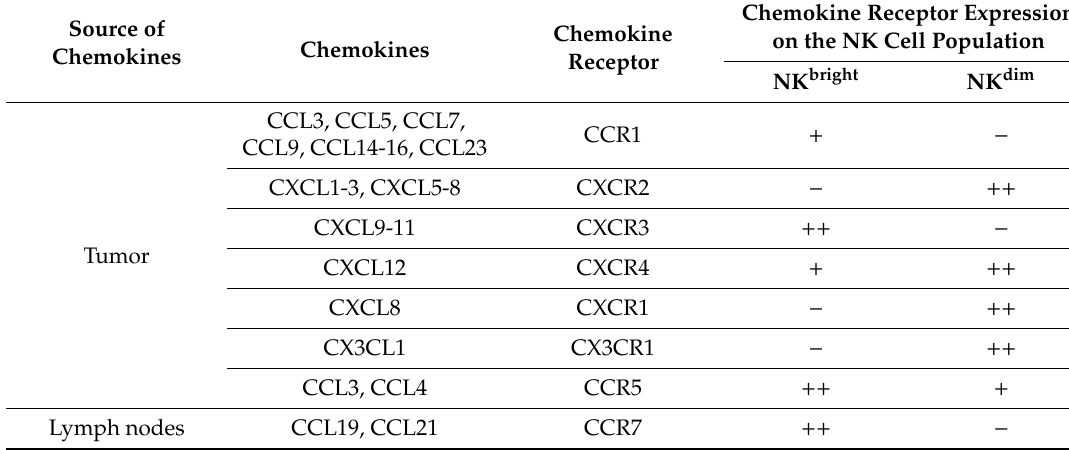
Table 1. Summary of chemokine receptors expressed by NK cells subpopulations and their respective ligands expressed by tumor or lymph